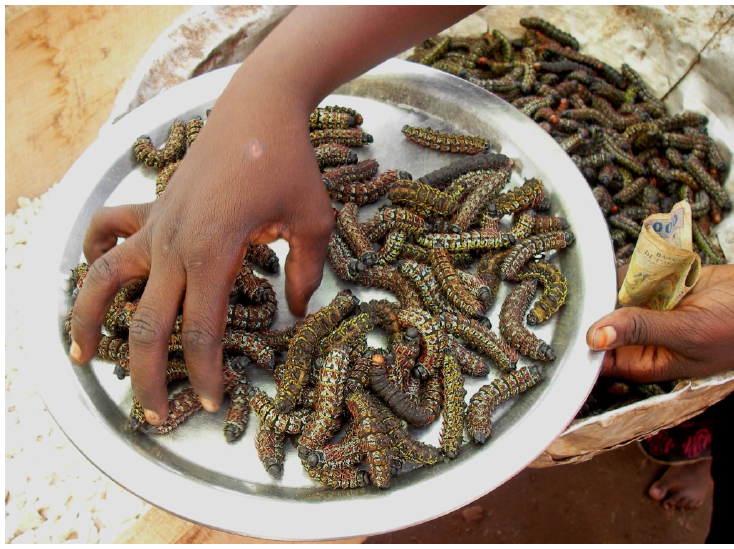
Figure 2. Living caterpillars sold on a Central African Market (image by S. Tchibozo).